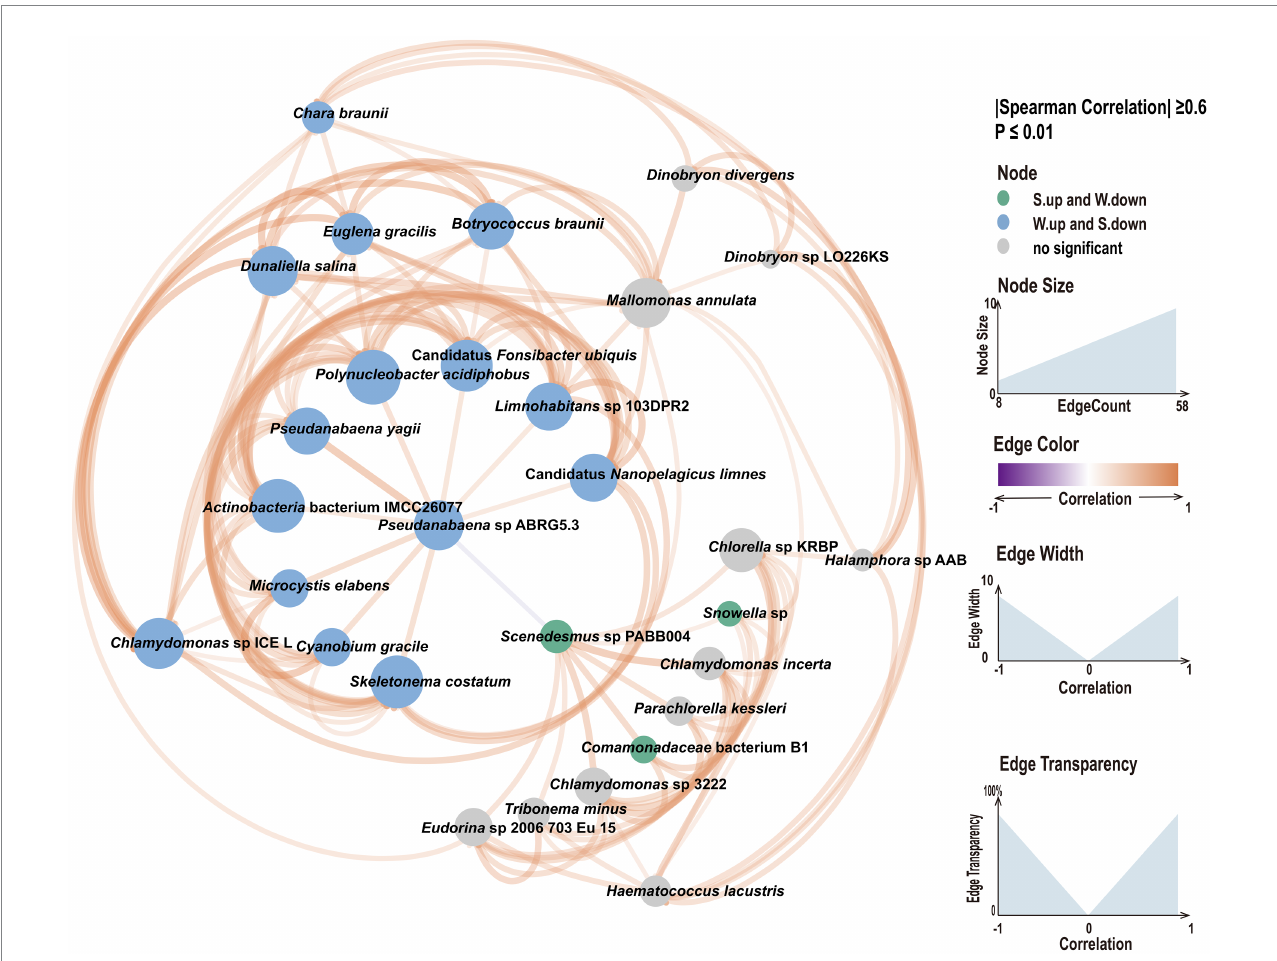
FIGURE 3 Network analysis of dominant species with significant differences among samples. The thickness and thinness of the lines indicate strong and weak correlations, respectively. Orange lines indicate positive correlations, and gray lines indicate negative correlations. Blue circles indicate taxa with higher abundances in water samples, and green circles indicate taxa with higher abundances in sediment